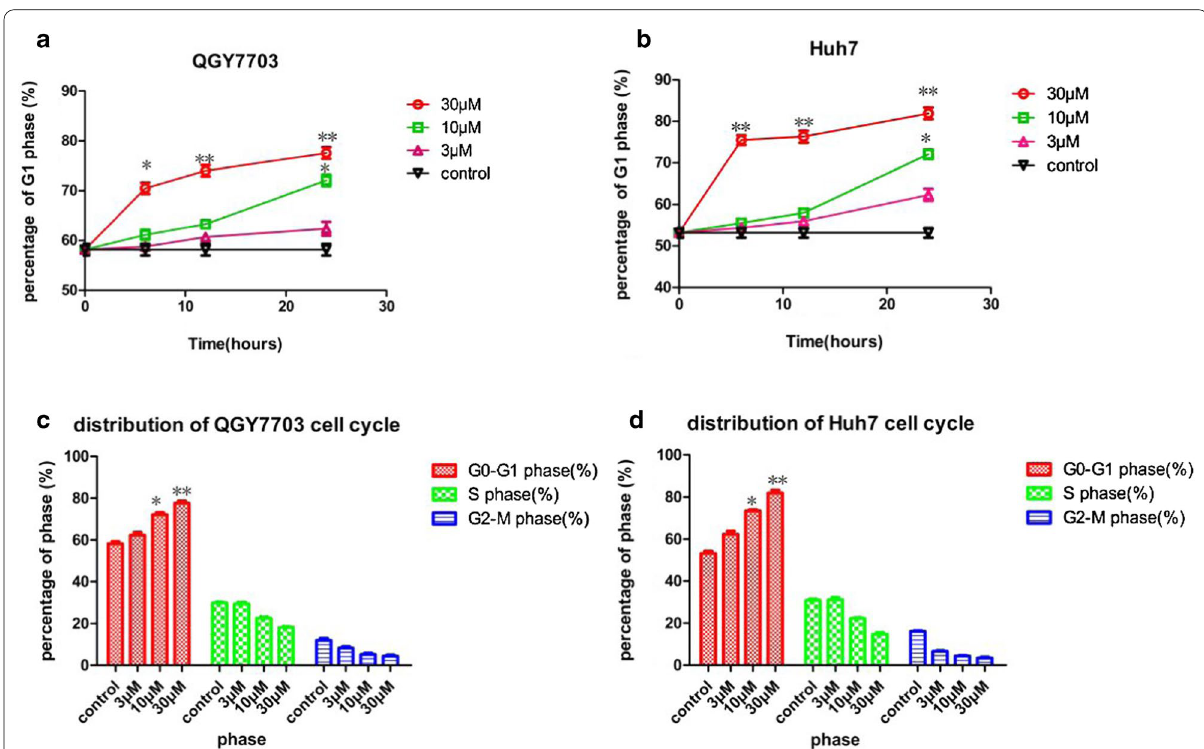
Fig. 2 Effect of vanoxerine dihydrochloride treatment on cell cycle distribution in QGY7703 and Huh7 cells. a QGY7703 and b Huh7 cells were treated with different concentrations (3, 10 and 30 μM) of vanoxerine dihydrochloride for 6, 12, 24 hours. Cell cycle distributions were measured by flow cytometry. Vanoxerine dihydrochloride dose‑ and time‑dependently increased the % of cells in G1 phase, as compared to PBS control. b The cell cycle distributions at 24 h after 10 μM vanoxerine dihydrochloride treatment. The bar graph indicated the percentage of the G1, S and G2‑M phases. *p < 0.05, significantly different from the control PBS treatment group